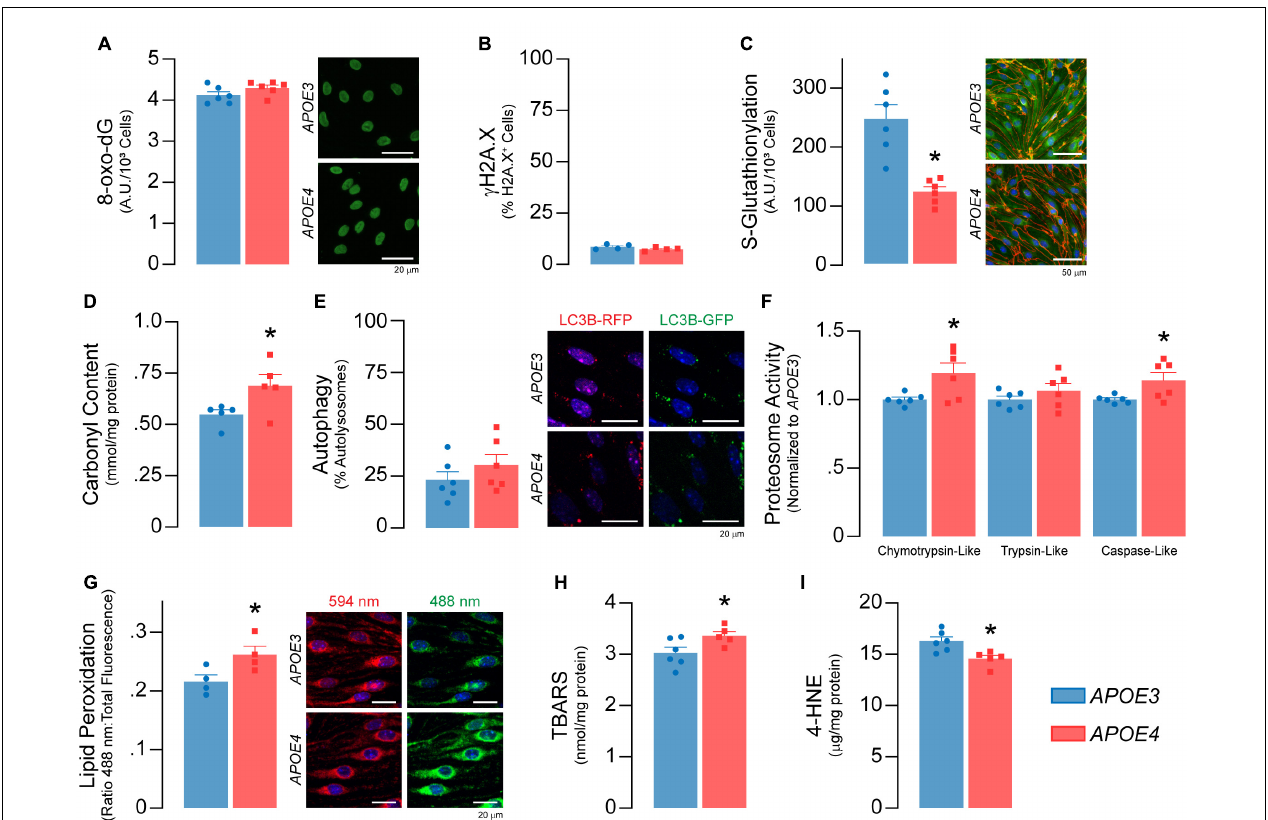
FIGURE 6 | Higher levels of oxidative damage to proteins and lipids in APOE4 brain endothelial cells. There are no APOE genotype effects on markers of DNA damage, including (A) levels the oxidized deoxyguanosine derivative 8-oxo-2’-deoxyguanosine and (B) the double-stranded DNA breaks marker γ H2A.X ( n = 4). (C) Protein glutathionylation limits irreversible oxidative damage to cysteine thiol groups on proteins. APOE4 brain endothelial cells have ∼ 50% lower S-glutathionylated protein levels, that could be due to the lower GSH:GSSG ratio induced by reactive oxygen species ( Figure 5J ) and/or lower levels glutathione transferases ( Supplementary Table 2 ; Gstt3, Gstm2, Gstp1, Gstm1, Gstt2). (D) The lower protection of proteins with APOE4 could lead to irreversible oxidation of amino acid side chains referred to as carbonylation. Protein carbonylation is ∼ 25% higher with APOE4 as measured by 2,4-dinitrophenylhydrazine (DNPH) binding ( n = 5). In addition, while there was no difference in (E) autophagy, (F) chymotrypsin-like and caspase-like proteosome activity are higher with APOE4 , potentially to degrade damaged proteins. (G) Lipids are sensitive to the effects of reactive oxygen species through peroxidation, which we measured using a ratiometric fluorescent indicator (BODIPY 581/591 C11) that changes from red to green upon lipid peroxidation. In APOE4 brain endothelial cells, lipid peroxidation is higher, as evidenced by ∼ 20% higher ratio of green:total fluorescence ( n = 4). In addition, (H) levels of lipid peroxidation products, called TBA reactive substances, are ∼ 11% higher ( APOE3 n = 6, APOE4 n = 5), although (I) 4 - hydroxynonenal levels are ∼ 11% lower as assessed by ELISA ( APOE3 n = 6, APOE4 n = 5). Data is expressed as mean ± S.E.M. * p < 0.05 by Student’s t -test with n = 6 (unless otherwise specified